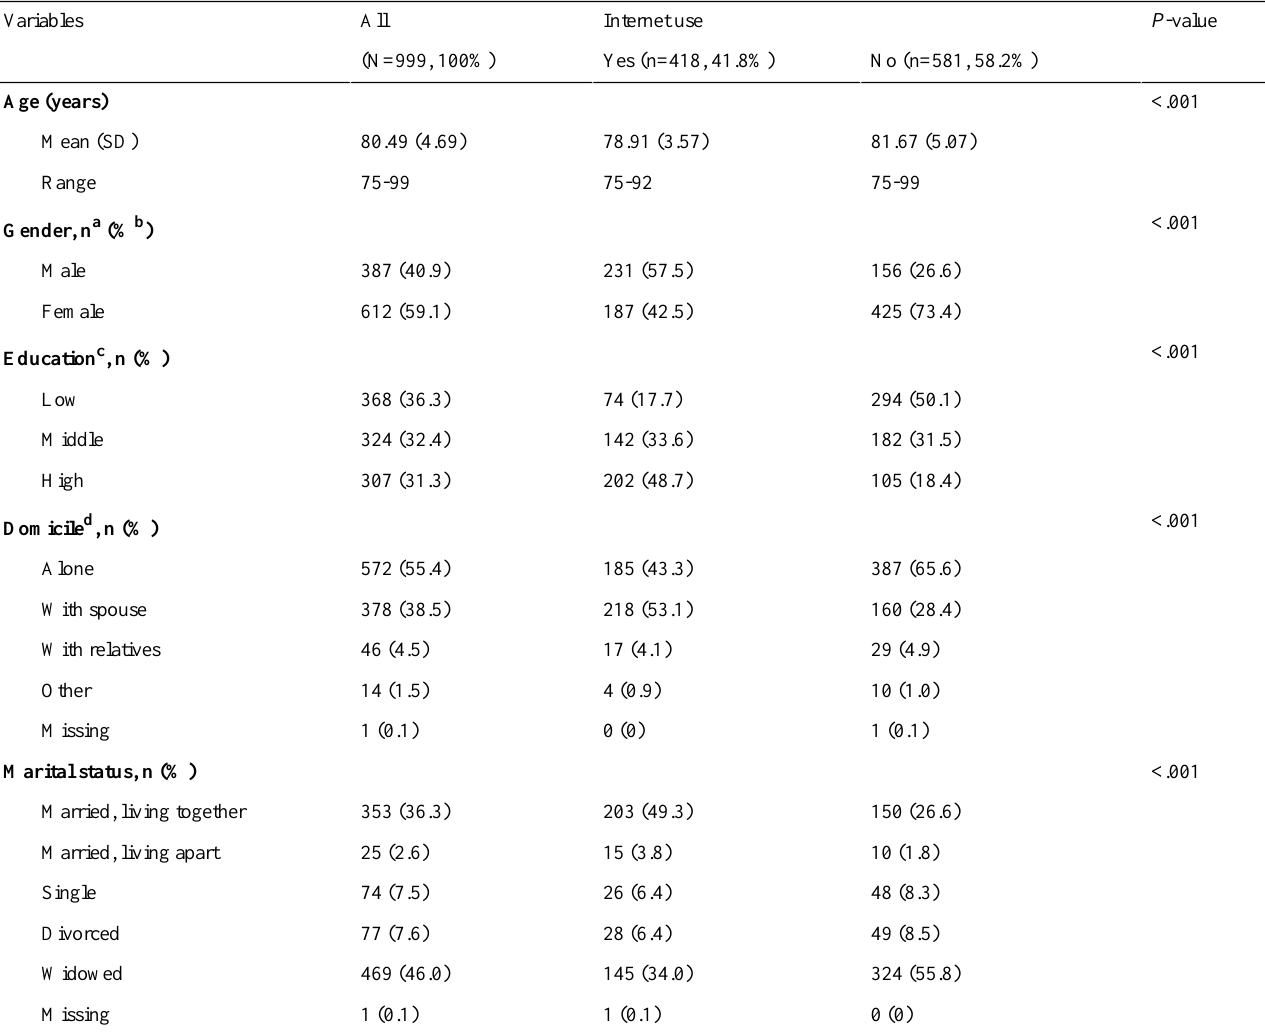
Table 1. Sociodemographic characteristics of the sample (N=999).